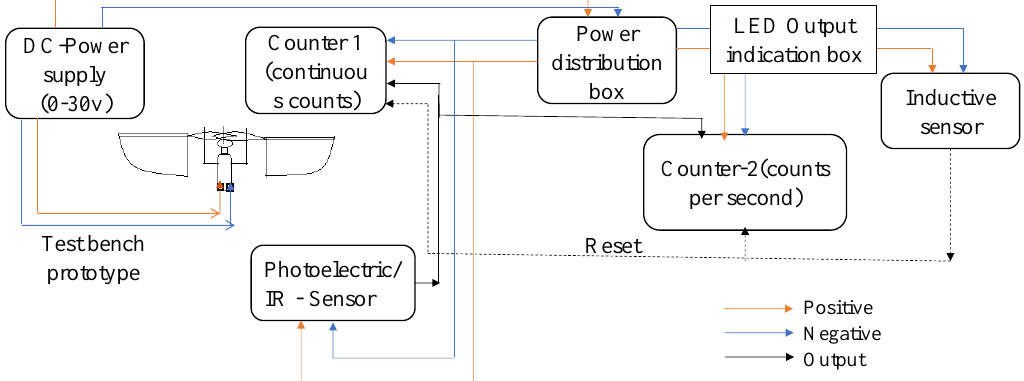
Figure 23. Schematic diagram of flapping frequency measuring setup. motor ’ s input voltage. As the input voltage increases from 1.5 to 4.5 volts, the IR sensor ’ s flapping measurement exhibits a modest linear variation. Figure 24 illustrates that our proposed prototype can achieve a maximum frequency of 35 Hz at a maximum voltage of 4.5 v, here F1 to F7 are the several sets of measurements conducted to observe the differ- ences in flapping frequency measurements. It is seen that the greatest fluctuation in flaps per second occurs between the 2.5 to 4 volts range of input.